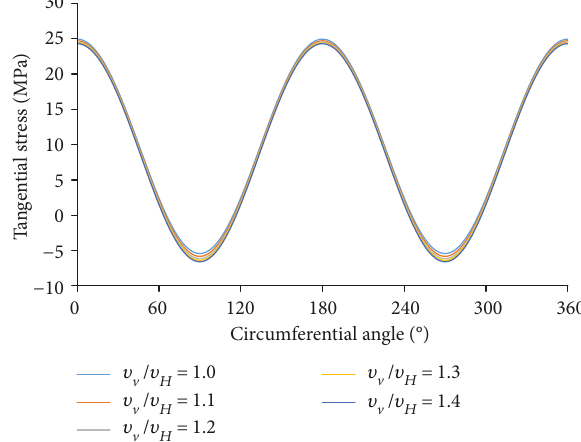
Figure 10: The relationship curves between tangential stress and circumferential angle of di ff erent υ v / υ H